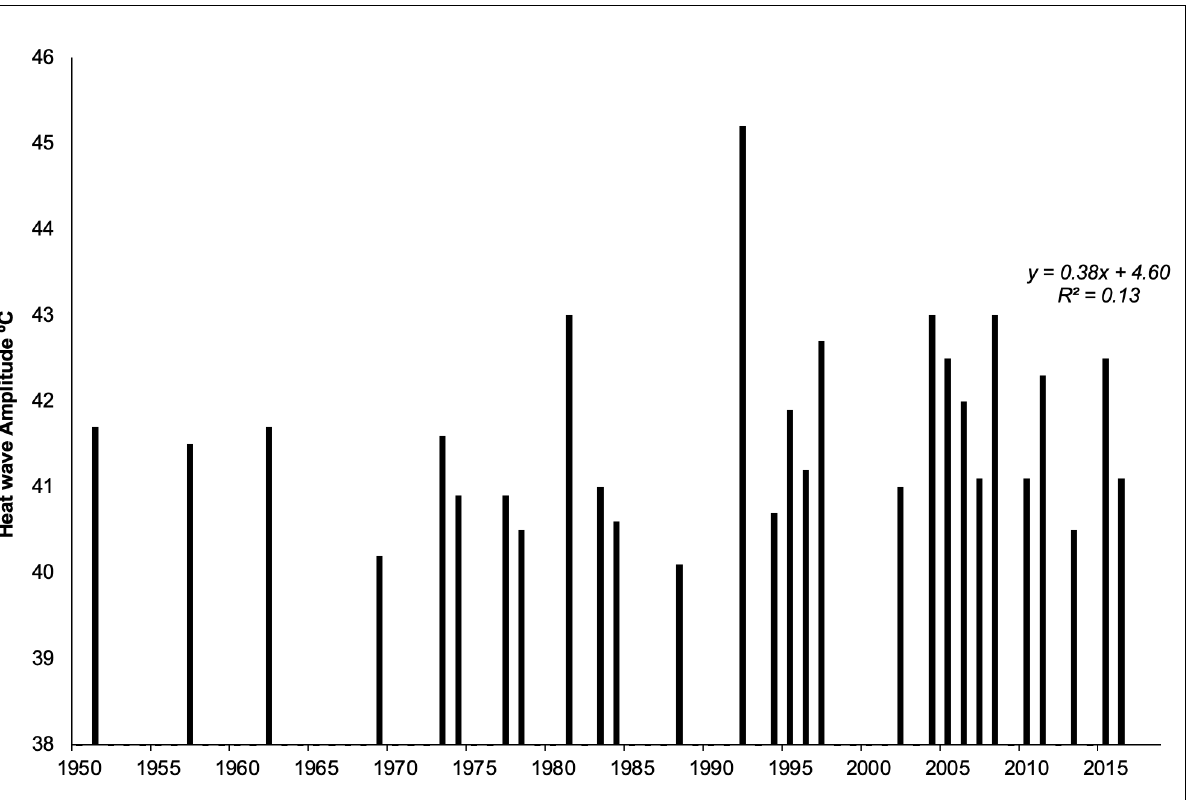
Figure 6: Annual heatwave amplitudes (i.e. highest temperature per year during periods associated with a heatwave) for northernmost Limpopo Province